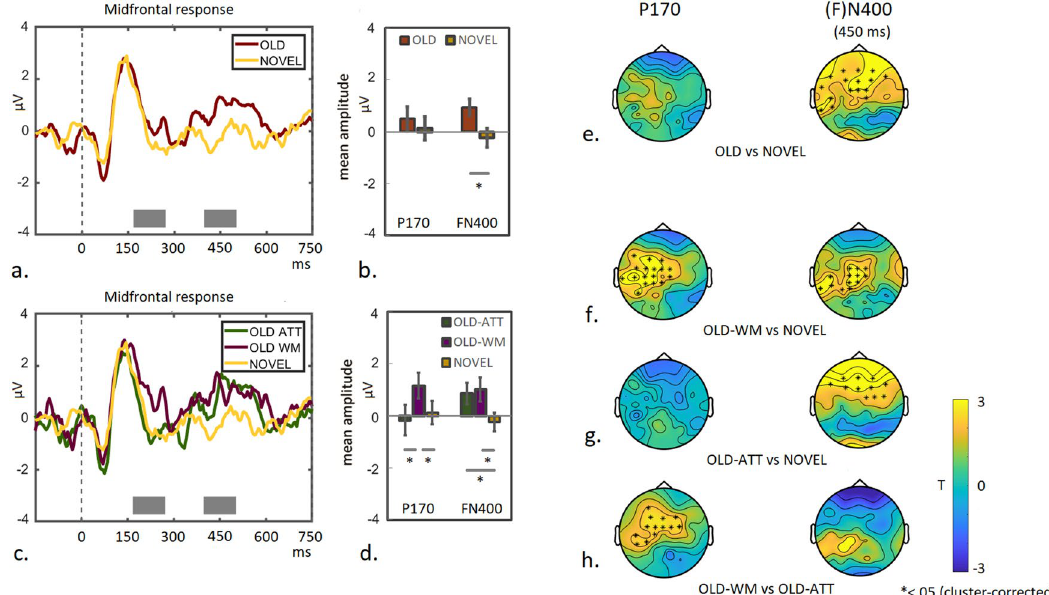
Figure 6. P170 and FN400 modulation and associated topographic activity distributions during the post-hoc recognition task. ( a ) The midfrontal response is shown for 750 ms post array-onset during the recognition task, for previously shown (OLD) and newly created colour-arrays (NOVEL). Mean amplitudes of the P170 (main peak and late modulation) and FN400 component (indicated by gray boxes in a ) are plotted per condition ( b ). ( c ) The midfrontal response is shown for 750 ms post array-onset for all conditions separately, ie. colour- arrays previously shown during the ATT- or WM condition (OLD-ATT and OLD-WM), or newly created colour-arrays (NOVEL). Mean amplitudes of the P170- and FN400 components (indicated by gray boxes in c ) are plotted per condition ( d ). ( e ) Topographic T-maps of between-condition differences are shown for the OLD- versus NOVEL contrast for the time-window corresponding to the P170 component (left panel), and the late FN400 peak (450 ms; right panel). Strong positive modulation is visible around midfrontal channels at 450 ms, which corresponds to the described pattern of the FN400 component, but also extends posteriorly to central- and left temporal electrodes. Topographic T-maps displaying between-condition differences are shown per time-window for the OLD-WM vs NOVEL contrast ( f ) the OLD-ATT vs NOVEL contrast ( g ) and the OLD-WM vs OLD-ATT contrast ( h ). Maps for the P170 time-window are shown in left panels and maps for the FN400 peak (450 ms) in right panels. Asterisks indicate significant differences ( p < .05 cluster-corrected). These results indicate that re-exposure to colour-arrays which previously had been shown during WM-trials